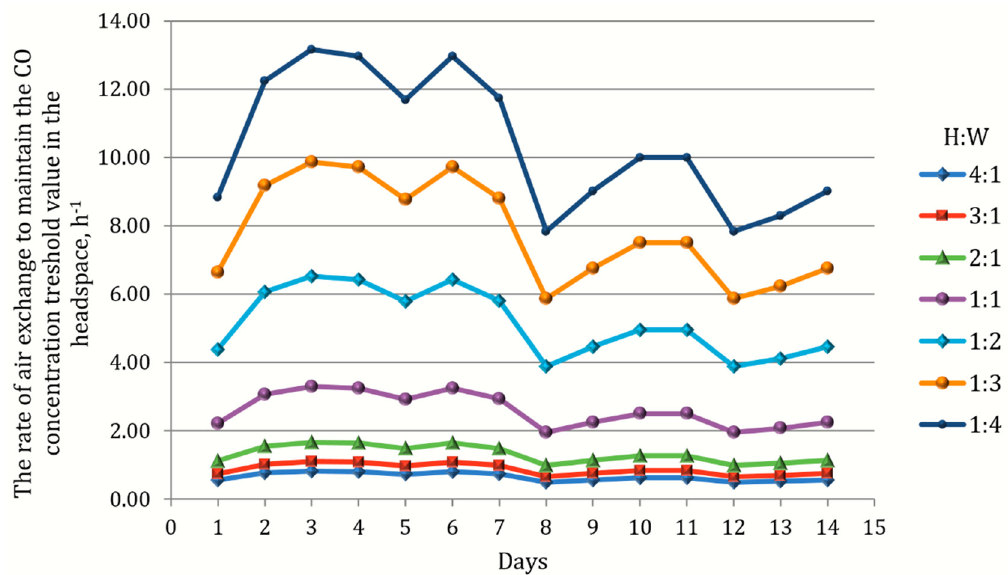
Figure 6. Rate of air exchange to mitigate CO accumulation and maintain the headspace CO concentration below the 100 ppm threshold.